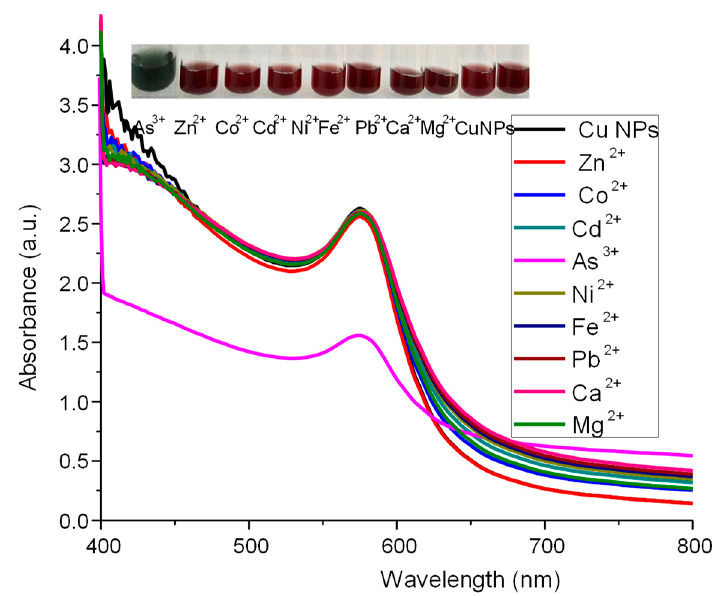
Figure 6. UV-Vis spectra showing the effect of adding As 3+ and other metal ions to Rano-Cu NP solution; inset picture monitors the color change upon addition of mentioned ions to Rano-Cu NPs.